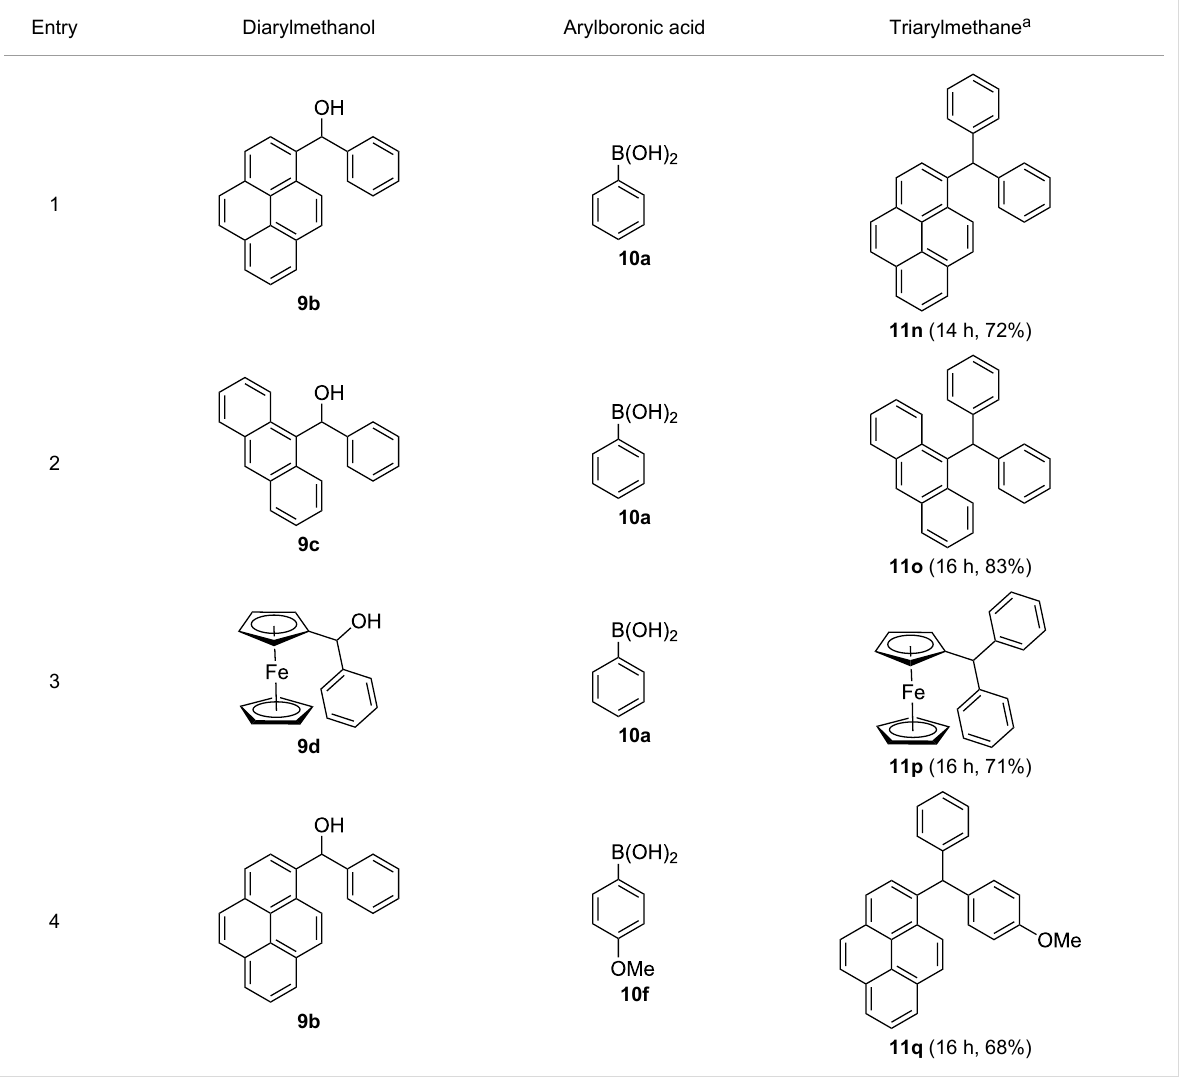
Table 3: Scope of diarylmethanol 9b–d in the copper-catalyzed coupling